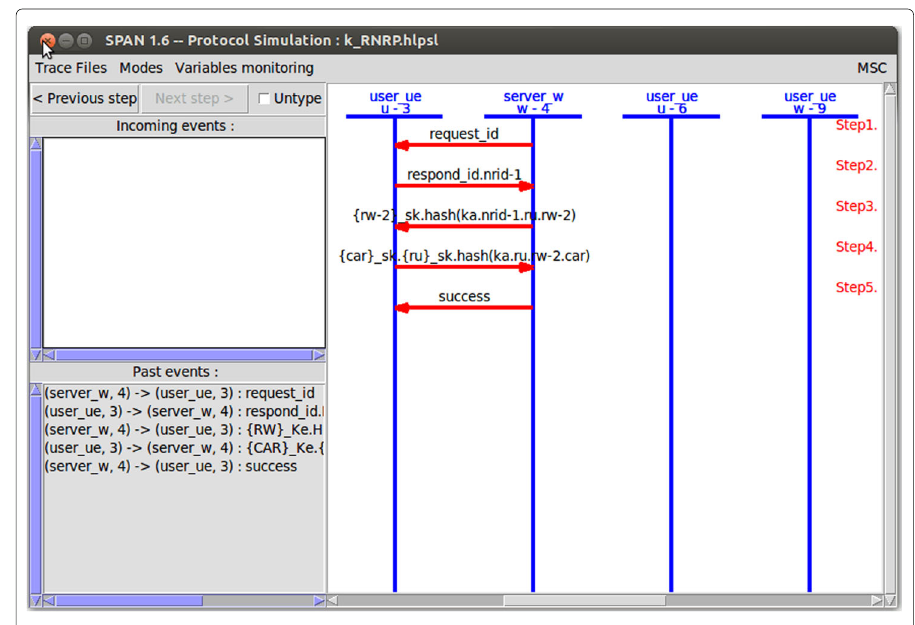
Fig. 10 The simulation of RNRP protocol